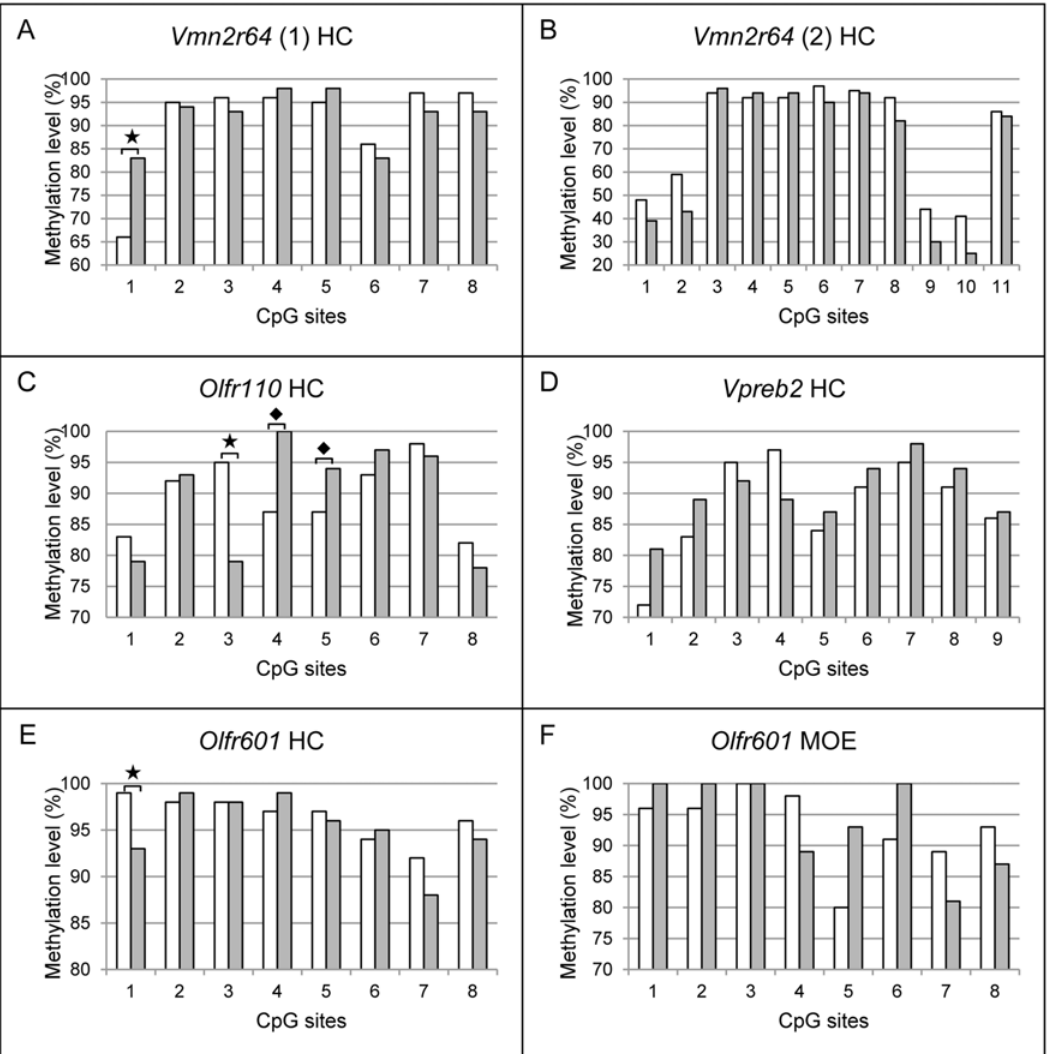
Fig 4. Site-specific DNA methylation levels of six CpG islands in control and ethanol-exposed offspring (P28). Site-specific methylation levels of Vmn2r64 [A: upstream island (1) and B: CpG island in gene-body (2)], Olfr110 (C, upstream), Vpreb2 (D, in gene-body), and Olfr601 (E, in gene-body) in hippocampus (HC) and Olfr601 (F, in gene-body) in main olfactory epithelium (MOE). The methylation levels of CpG1 in Vmn2r64 (1)(A), CpG3 in Olfr110 (C), and CpG1 in Olfr601 (E) were significantly changed between the two experimental groups ( * p < 0.05, Mann-Whitney). Notable changes are marked by diamonds ( ♦ ): CpG4 and CpG5 in Olfr110 (p = 0.07 and p = 0.11, Mann-Whitney, respectively). Controls are illustrated in white and ethanol-exposed offspring in grey